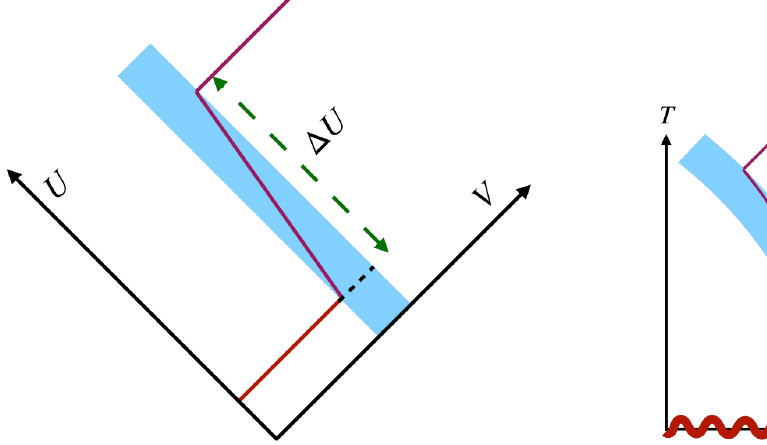
Figure 5. The trajectory of a late outgoing wave packet (red curve) originated from the big bang, or any IR cutoff (wavy red curve), inside a time- like collapsing shell (blue